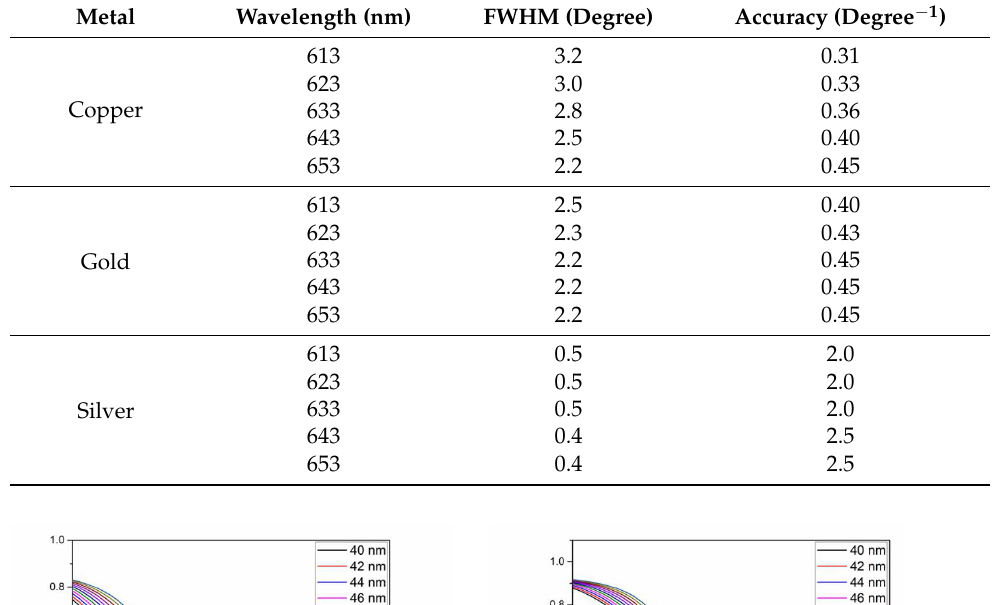
Table 1. The FWHM and accuracy of copper, gold, and silver thin film at different wavelengths.